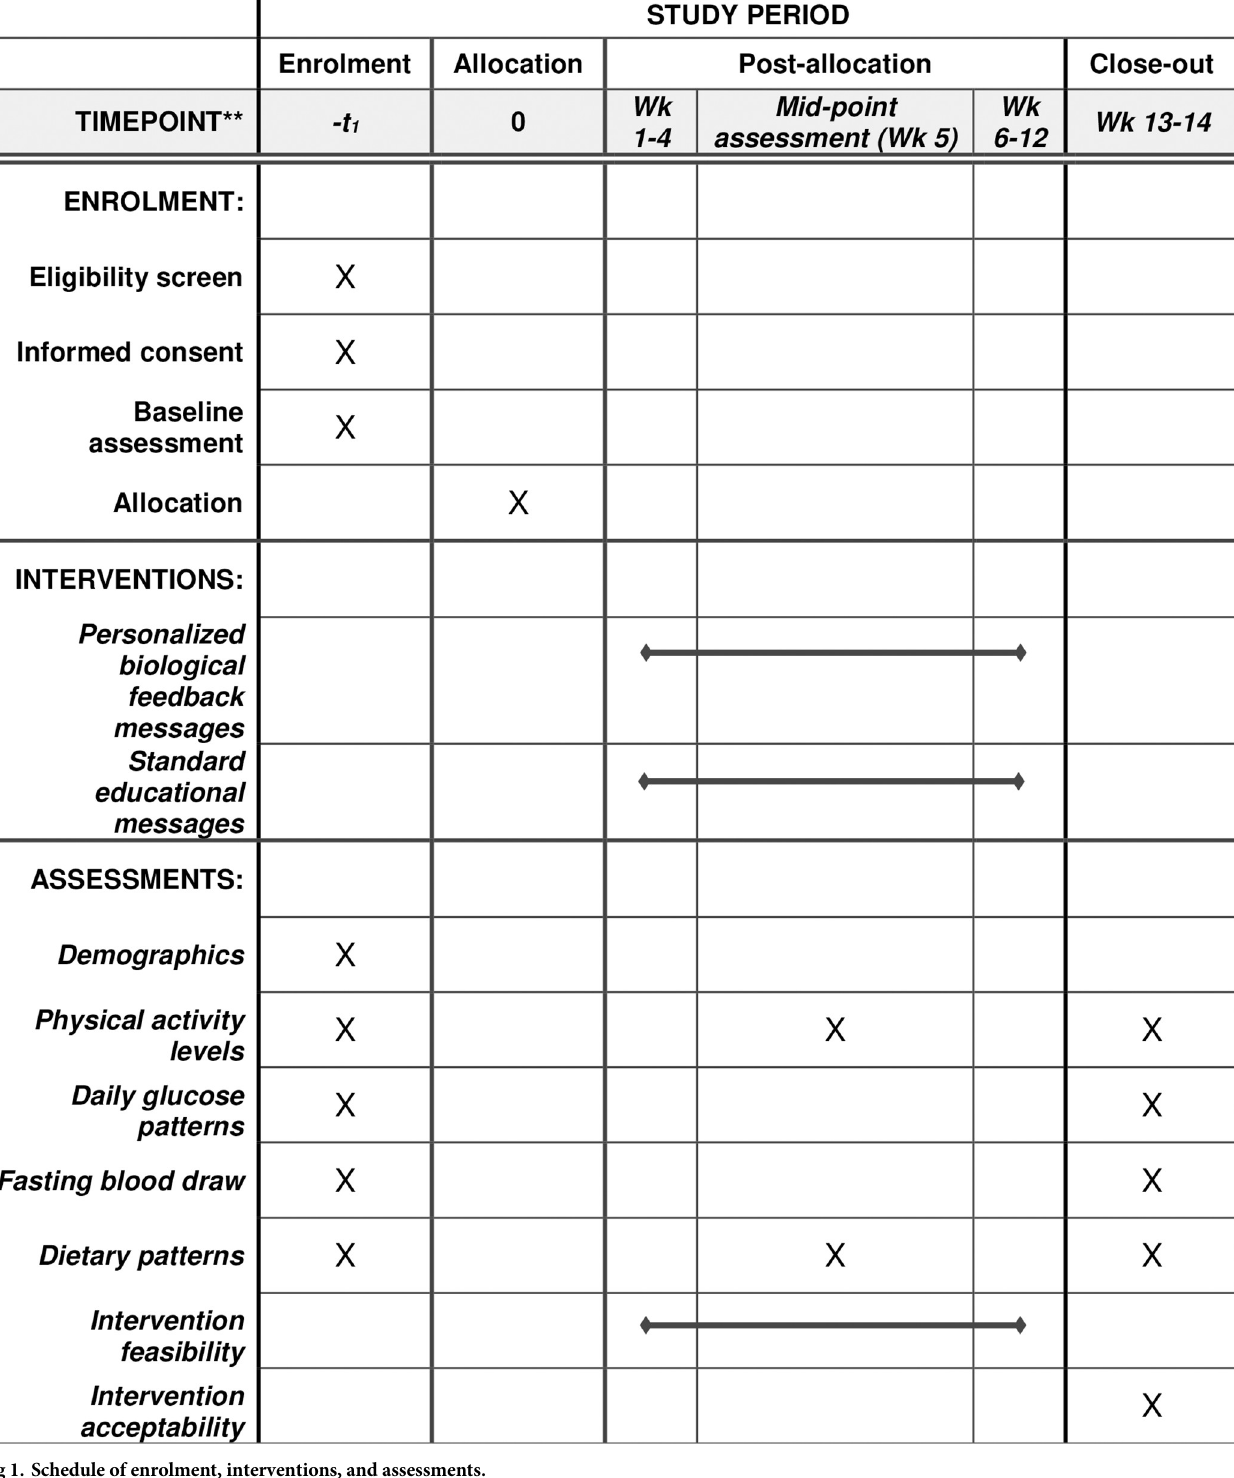
PLOS ONE | https://doi.org/10.1371/journal.pone.0274492 September 13,